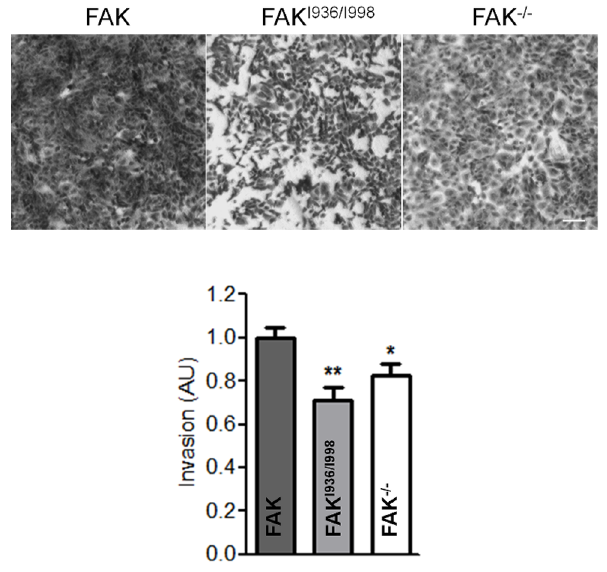
Figure 7. Invasion of FAK -/- , wild-type FAK and FAK I936/I998 cells co-transfected with active Src. Transfected cells were seeded in Matrigel-coated Boyden chambers and allowed to invade for 24 h. Invading cell nuclei were stained with crystal violet and ODs were measured at 595 nm. Bright field images were taken at 4 6 magnification. Scale bar, 100 m m. (P=0.0030, F=7.795; *p , 0.03, **p , 0.002 versus wild-type FAK cells from 3 independent experiments done in